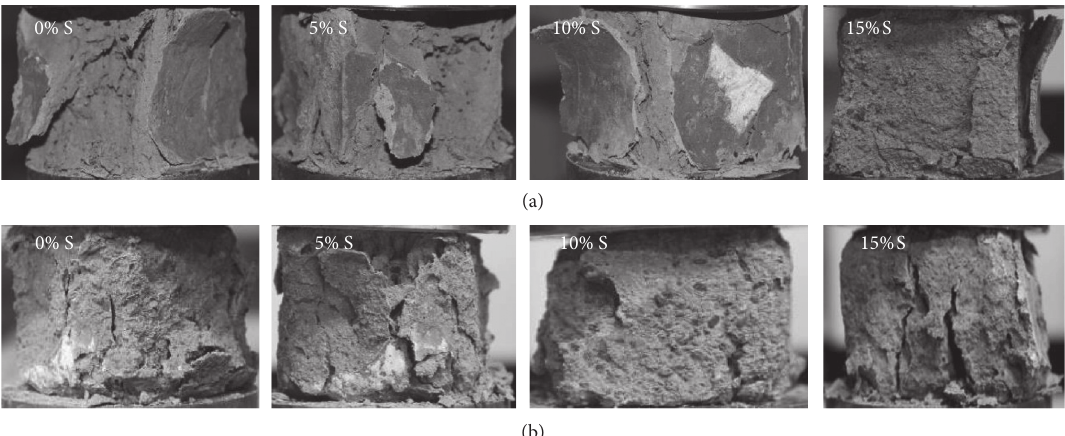
Figure 6: Failure characteristics of CGFB samples immersed in 0–15% sodium sulfate solutions at the (a) third and (b) fifteenth drying- wetting